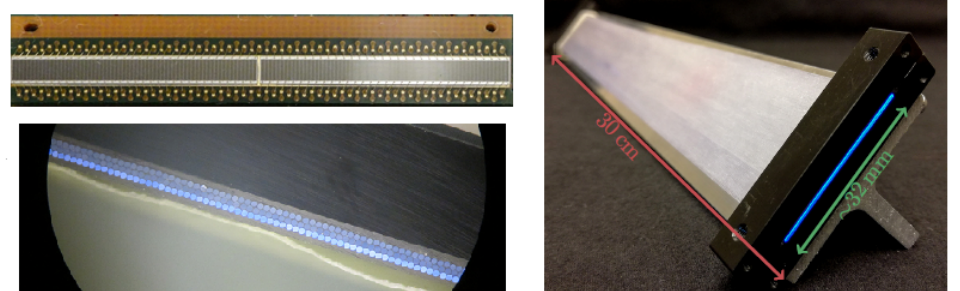
Figure 8: 128 ch. Si-PM array used for the readout of scintillating fibers (top left), microscope photo of a three layer staggered SciFi ribbon profile (bottom left), and SciFi ribbon prototype close to the final size (right).